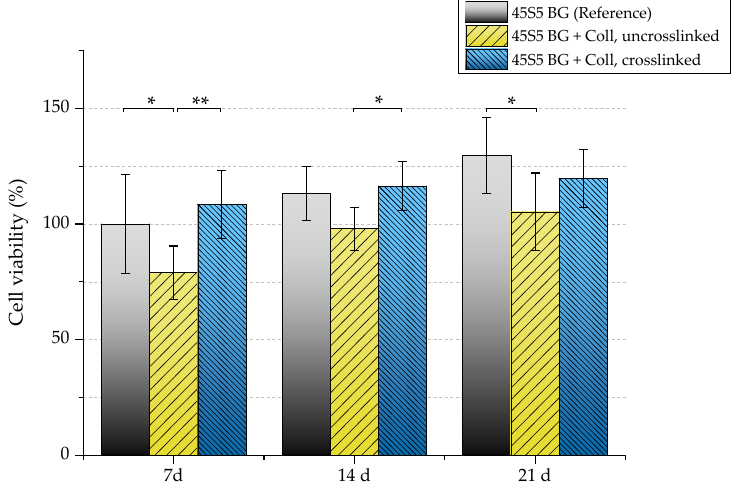
Figure 14. Cell viability of MG-63 cells of different scaffold types (absorbance at 450 nm) after 7, 14, and 21 days. Significance levels: * p < 0.05, ** p < 0.01 (Bonferroni’s post-hoc test was used).